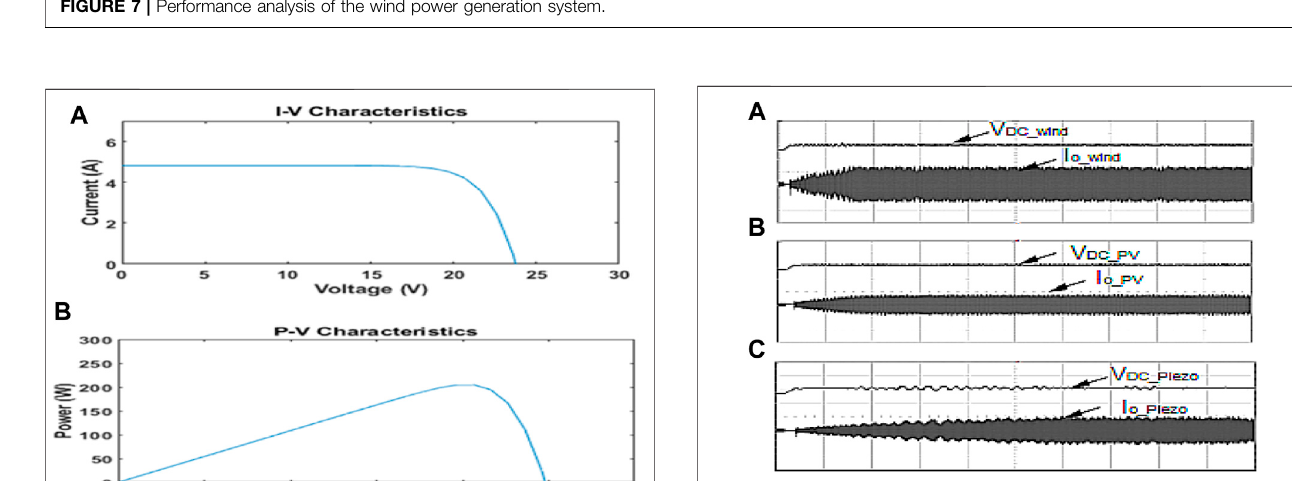
FIGURE 7 | Performance analysis of the wind power generation system.